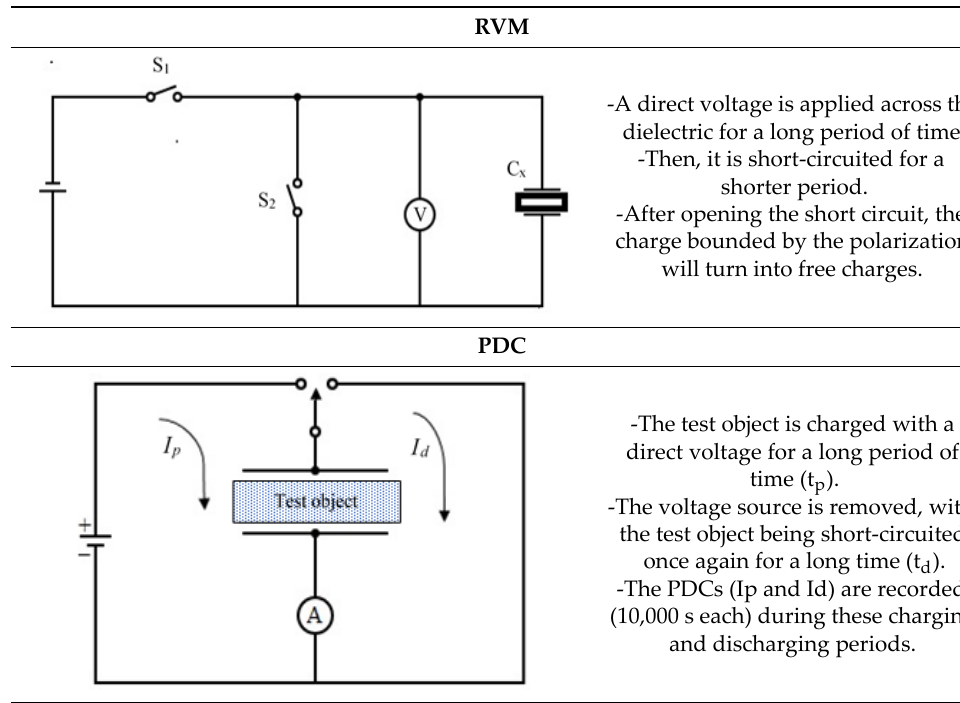
Table 7. The basic circuits to measure RVM and PDC.